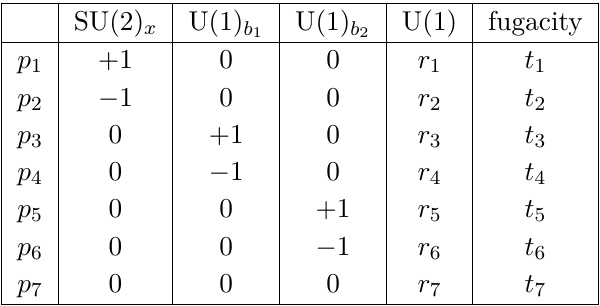
Table 59 . Global symmetry charges on the extremal brick matchings p i of Model